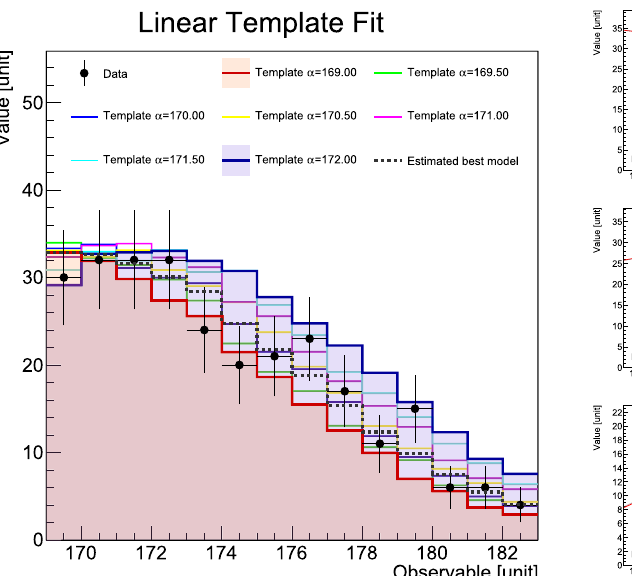
ence values of the parameter of interest α . Only nine selected “bins” i are displayed. The red line shows the linearized model ˆ y i (α) , Eq. (15), in the respective bin, and the full circles are again the pseudo-data. The dotted line indicates a weighted linear regression, which is not used